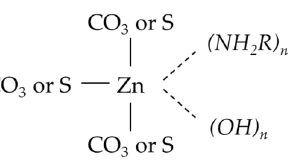
Figure 11. Complexation of amines and ZnS on smithsonite particles [22].